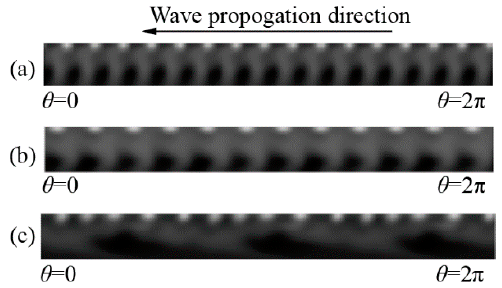
Figure 15. Circumferential view of concentration fluctuation when the crucible rotation is considered at Re T = 6.0 × 10 3 . ( a ) Re c = 234; ( b ) Re c = 701; ( c ) Re c = 234, Re s = 3506.